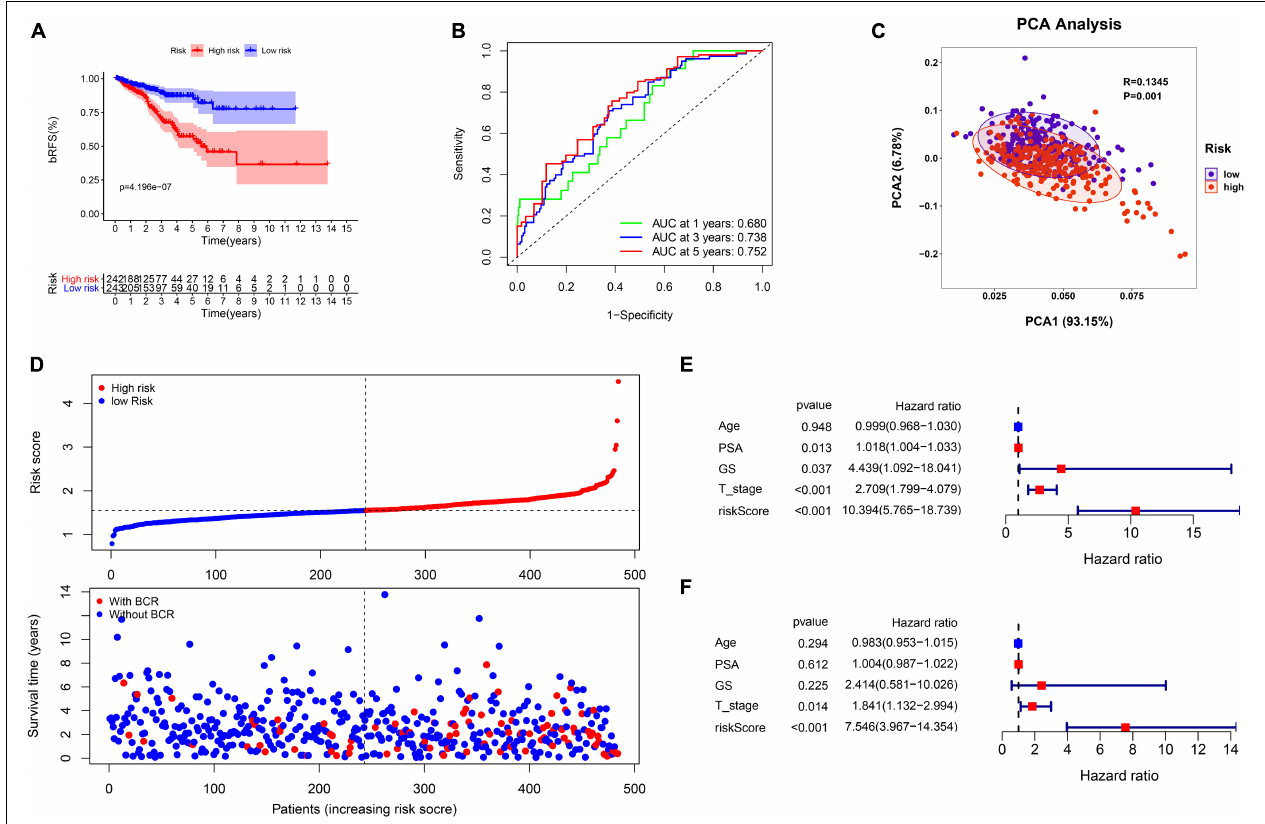
FIGURE 4 | The evaluation of prognostic signature in TCGA cohort. (A) The biochemical relapse-free survival (bRFS) analysis of the two subgroups stratified based on the median of risk scores calculated by the risk model. (B) Receiver operating characteristic (ROC) curve of model and clinical characteristics predicting 1-, 3-, and 5-year bRFS. (C) The two risk groups were distinguished by principal component analysis (PCA). (D) The curve of risk score and BCR status of the patients. (E,F) Univariate and multivariate Cox regression analyses showed that the risk score had prominent prognostic